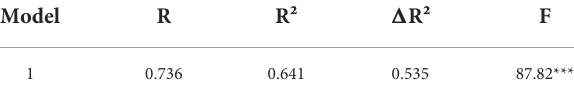
TABLE 12 Summary of the internalization problem